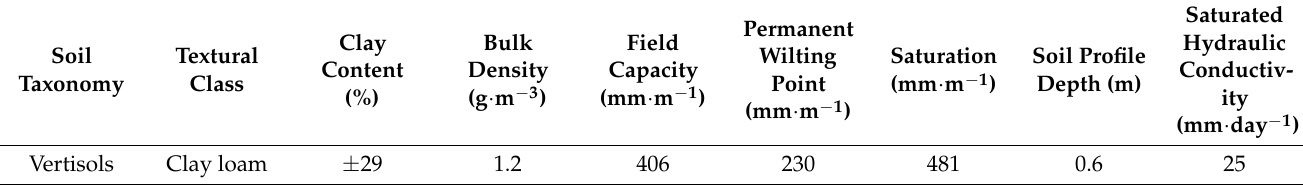
Table 2. Soil physical and hydraulic properties of Ukulinga experimental site.